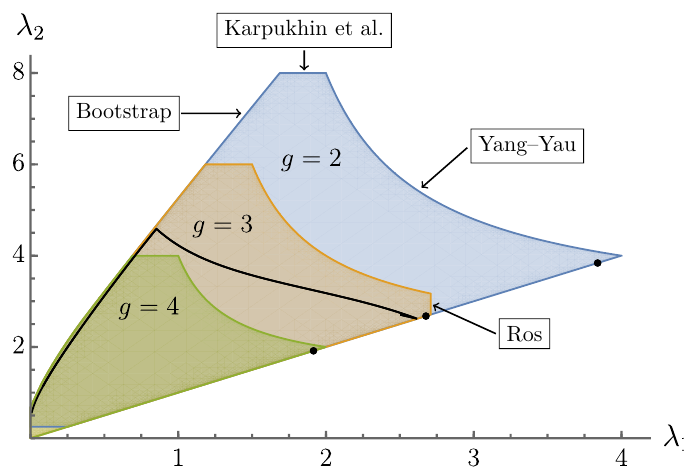
Figure 3 . Allowed regions for the first two nonzero eigenvalues of the Laplace-Beltrami operator on closed hyperbolic surfaces of genera 2, 3, and 4. The regions are shaped by the bounds of Yang-Yau [21] (as given in eqs. (2.2) and (2.3)), Otal-Rosas [18], Ros [24], and Karpukhin et al. [26], together with the numerical bootstrap bound. The regions shrink as g increases, except for the triangular region with λ 2 ≤ 1 / 4 , which is excluded by the Otal-Rosas bound only for g = 2 . The filled circles going from right to left correspond to the Bolza surface, the Klein quartic, and Bring’s surface, which are the closed hyperbolic surfaces of genera 2, 3, and 4 with the largest symmetry groups. These surfaces are conjectured to have the largest values of λ 1 for their genera [10, 60]. The black line corresponds to the eigenvalues of the genus-2 surfaces along the path ρ ( ‘ ) , defined in eq. (4.16), for ‘ ∈ [2 , 20] , computed using Hypermodes [9,